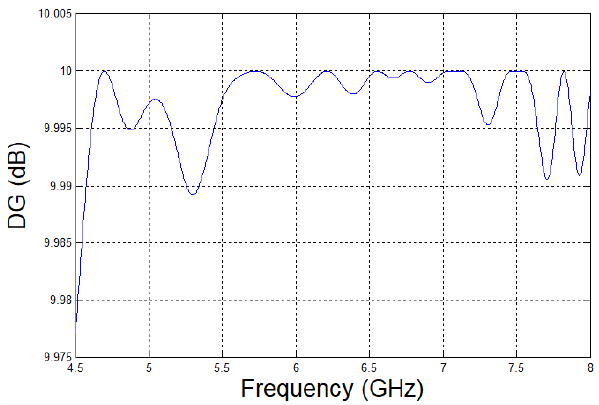
FIGURE 8: DG of MIMO antenna elements